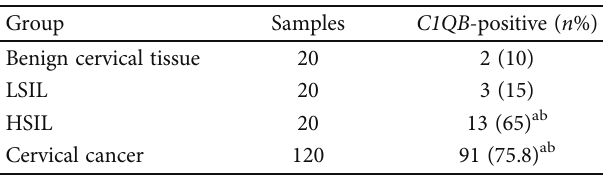
Figure 1: A fl ow chart showing retrieval of high-throughput data sets related to cervical cancer. TCGA, The Cancer Genome Atlas; GTEx, The Genotype-Tissue Expression; GEO, Gene Expression Omnibus; C1QB , complement C1q B chain. Table 1: Comparison of C1QB protein expression among di ff erent